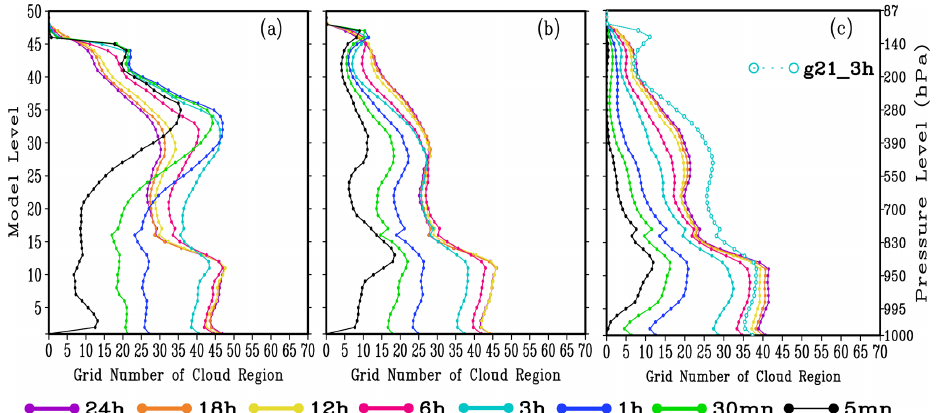
Figure 4. Vertical distribution of total number of cloud points at different forecast time simulated by F00 (a) , G21 (b) , and G00 (c) experiment, respectively (values given in number · 10000).